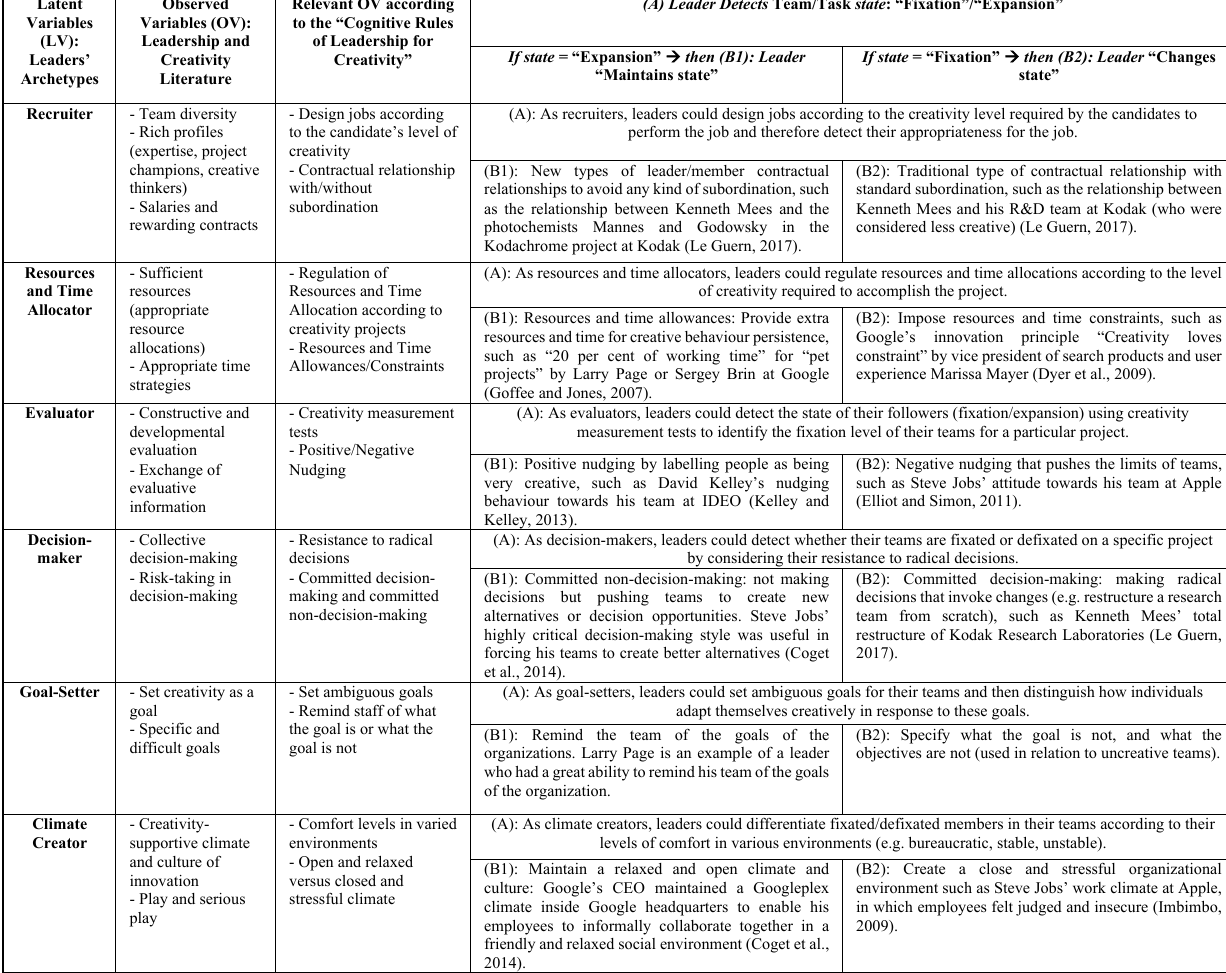
Table 3. Relevant observed variables for leadership defixation in organizational contexts Latent